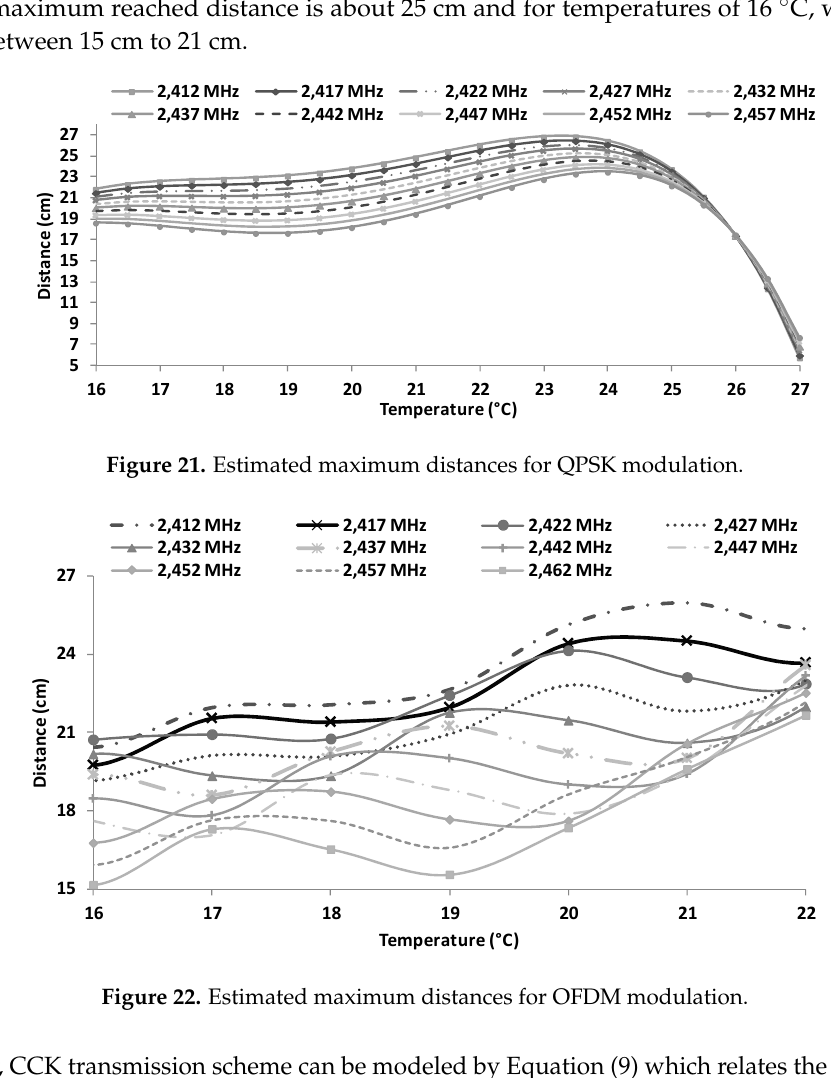
Figure 23. Estimated maximum distances for CCK transmission scheme.